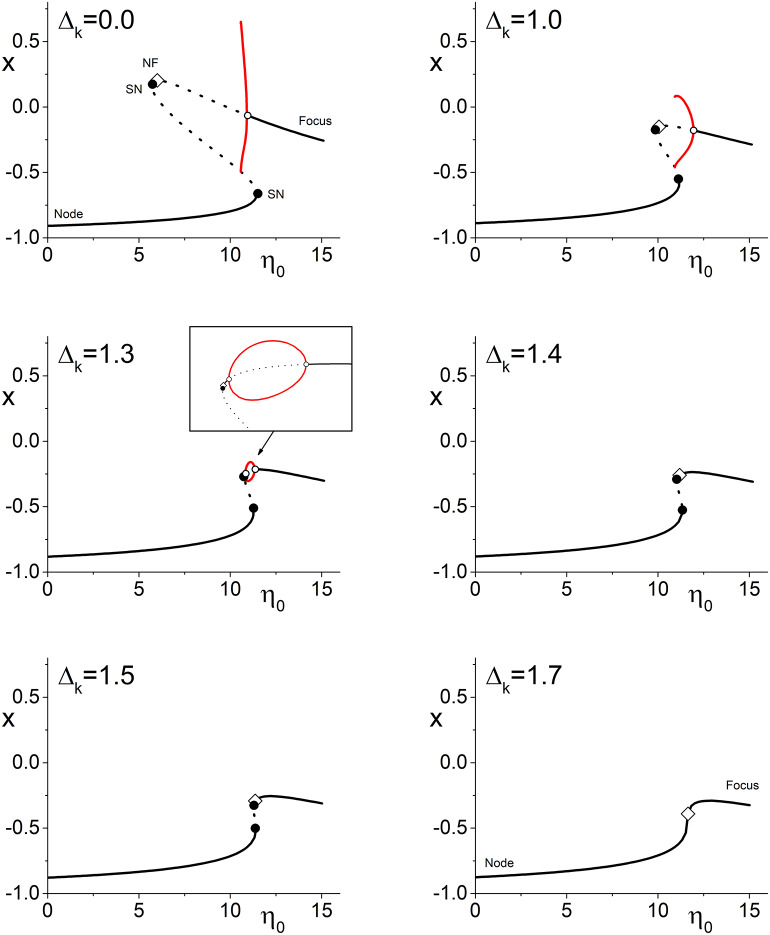
Case 2: One-dimensional bifurcation diagrams showing x = Re(z) vs. the parameter η0. The panels show the diagram for increasing values of Δk, the width of the coupling strength distribution. Stable (unstable) equilibria are represented by solid (dotted) black lines, and are nodes or foci as indicated. Open diamonds are node-focus transitions. The maximal and minimal values of x on stable limit cycles are represented by the red lines. Solid black circles are saddle-node bifurcations, and open circles are Hopf bifurcations. As Δk increases, the various bifurcations merge and disappear, but the node-focus transition remains. The other parameters are k0 = −9.0, Δη = 0.5, and n = 2.